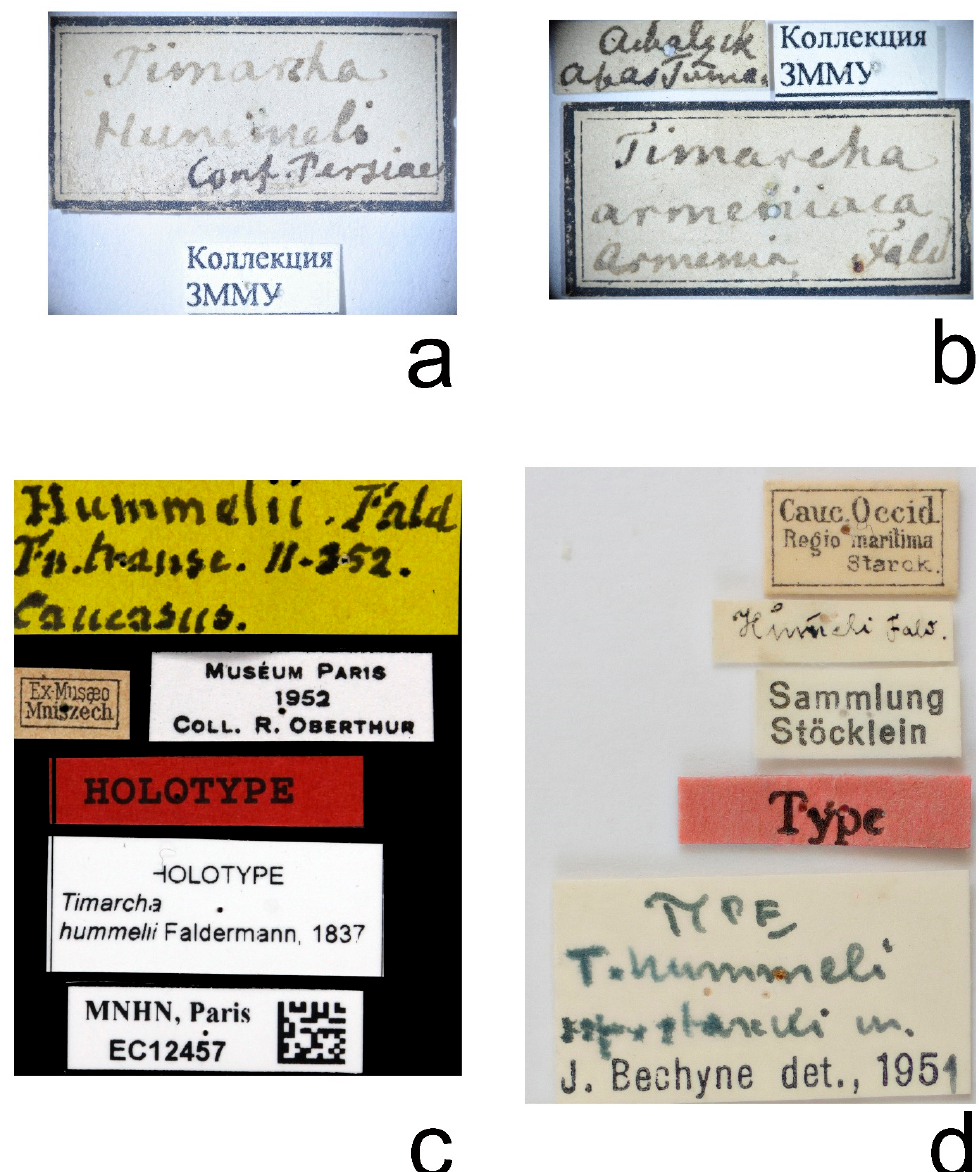
Figure 3. Labels of type and historical specimens. ( a ) Timarcha hummelii , neotype, male, ZMMU; ( b ) T. armeniaca , neotype, female, ZMMU; ( c ) T. hummelii , historical specimen, female, MNHN; ( d ) T. hummelii starcki , syntype, male, NMB.